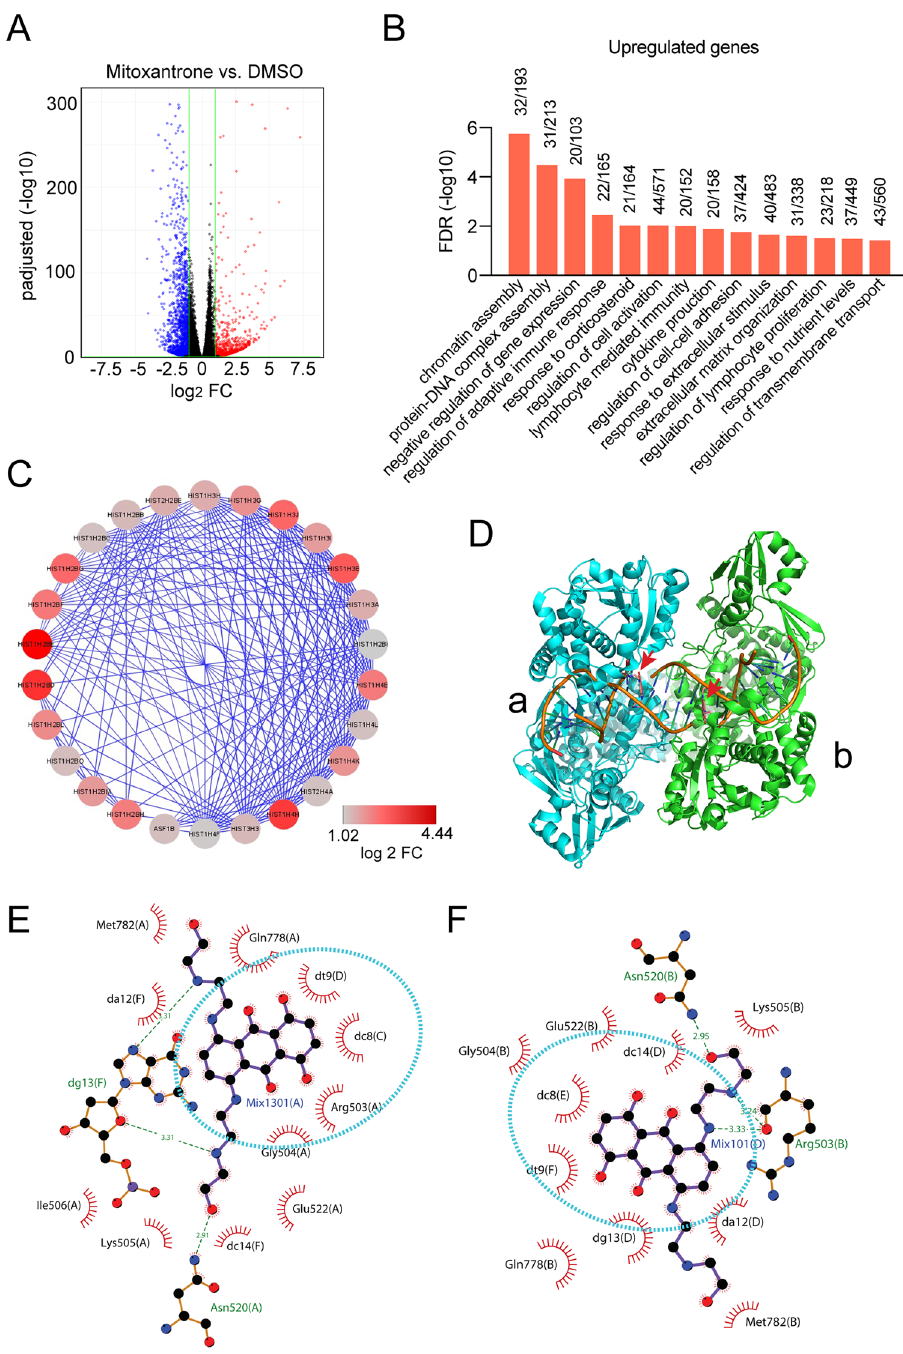
Figure 6. Gene expression profiling shows two major cellular targets of Mitoxantrone. (A) A volcano plot showing genes upregulated or downregulated by Mitoxantrone in HEK293T cells. (B) A list of significant pathways upregulated by Mitoxantrone. (C) Genes encoding nucleosome proteins are highly upregulated by Mitoxantrone. Shown is a gene interaction network highlighting nucleosome assembly-related genes induced by Mitoxantrone. Colors indicate fold change. (D) A crystal structure shows the binding of Mitoxantrone to a DNA-topoisomerase complex. Arrows indicate the two Mitoxantrone molecules each associated with a topoisomerase monomer. (E,F) LigPlot views of the molecular interactions between Mitoxantrone and the DNA-topoisomerase